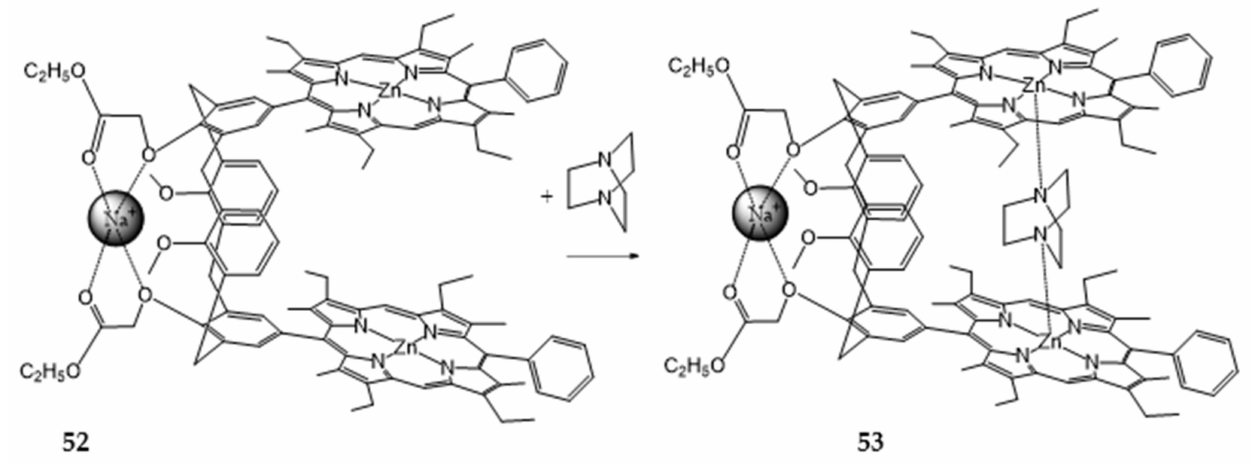
Scheme 14. 1:1 interaction between the receptor 52 and DABCO in the presence of Na +